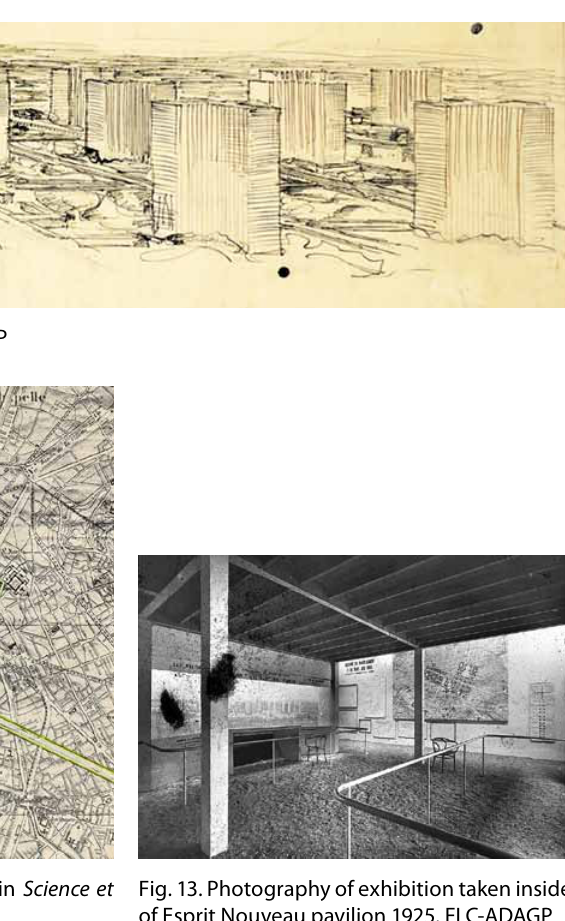
fig. 10. Sketch for diorama of Plan Voisin. flC31003 © flC-aDaGP